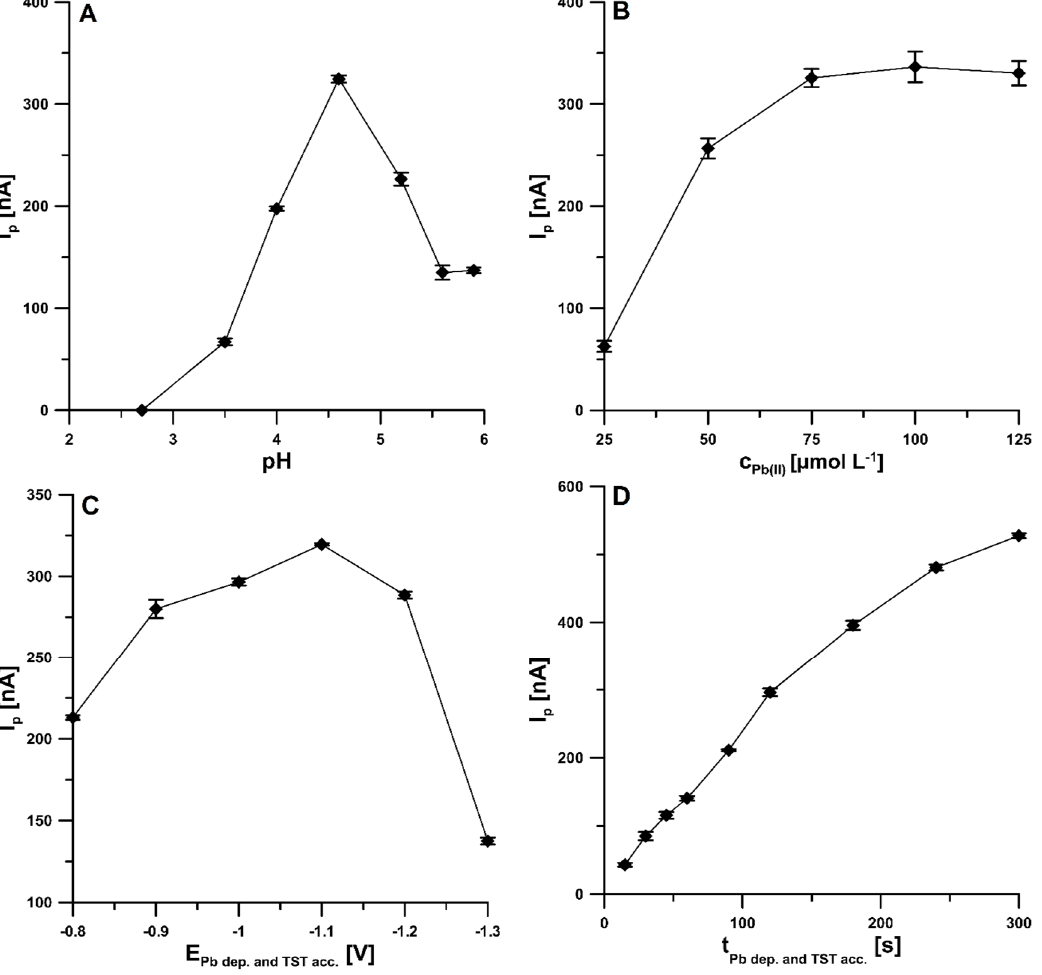
Figure 6. The dependence of pH ( A ), Pb(NO 3 ) 2 concentration ( B ), E Pb dep. and TST acc. ( C ), and t Pb dep. and TST acc. ( D ) on 1 × 10 − 8 mol L − 1 TST signal. The DPAdSV parameters: t m of 10 ms, Δ E A of 50 mV and ν of 40 mV s − 1 . The mean values of I p are given with the standard deviation for n = 3.